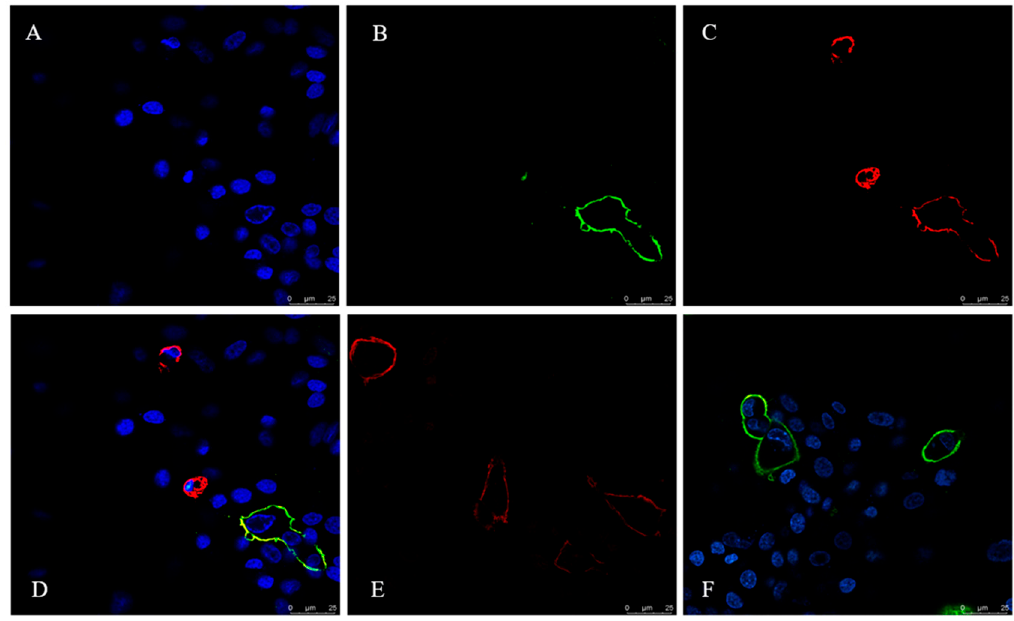
Figure 5. Co-localization of HA and canine tetherin in MDCK cells. ( A ) DAPI (4 ′ ,6-Diamidino-2-phenylindole) -positive cells; ( B ) CIV H3N2 HA protein is marked by FITC; ( C ) Canine tetherin is marked by Cy3; ( D ) A through C merged; ( E ) Canine tetherin is marked by Cy3 in the uninfected control cells; ( F ) HA protein is marked by FITC in the infected cells without canine tetherin.